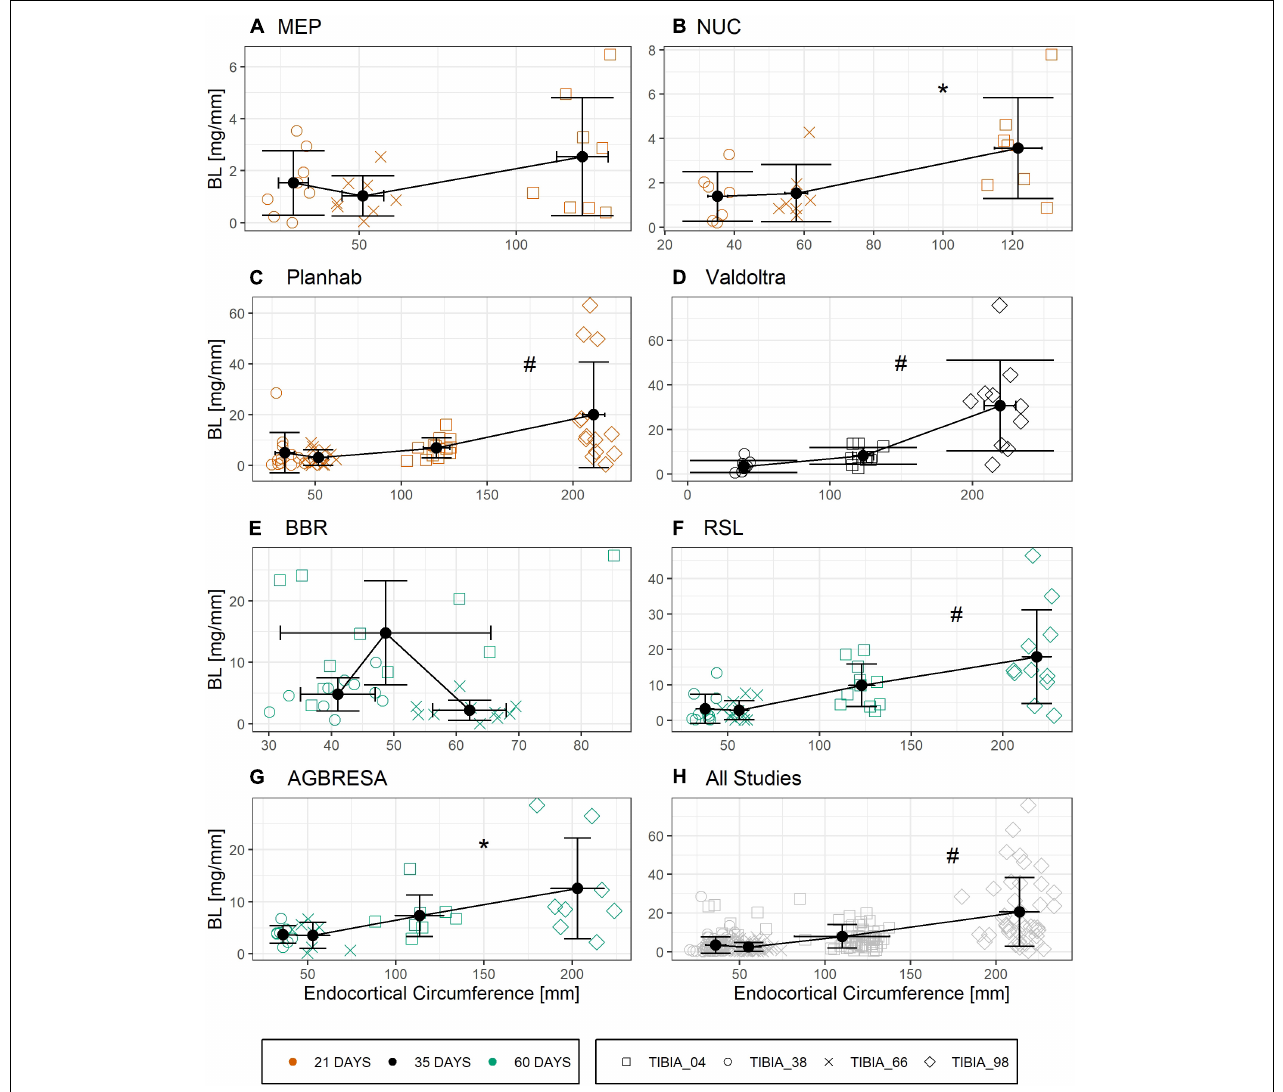
FIGURE 6 | Linear relationship of Bone Loss BL in [mg/mm] and endocortical circumference ENDO [mm] divided by study with (A) MEP, (B) NUC, (C) Planhab, (D) Valdoltra, (E) BBR, (F) RSL, (G) AGBRESA, and (H) all studies. The color indicates the bed rest duration and the shape represents the measurement site. Numbers in the measurement site names indicate the relative measurement position regarding the entire tibia length from distal to proximal. Presented are studies with at least three out of four bone sites. Black points are the mean value of each measurement site with error bars of BL and ENDO. Linear regression analysis showed significant associations across the different studies except for BBR and MEP. * denotes significant relationship with p < 0.01; # denotes significant relationship with p <